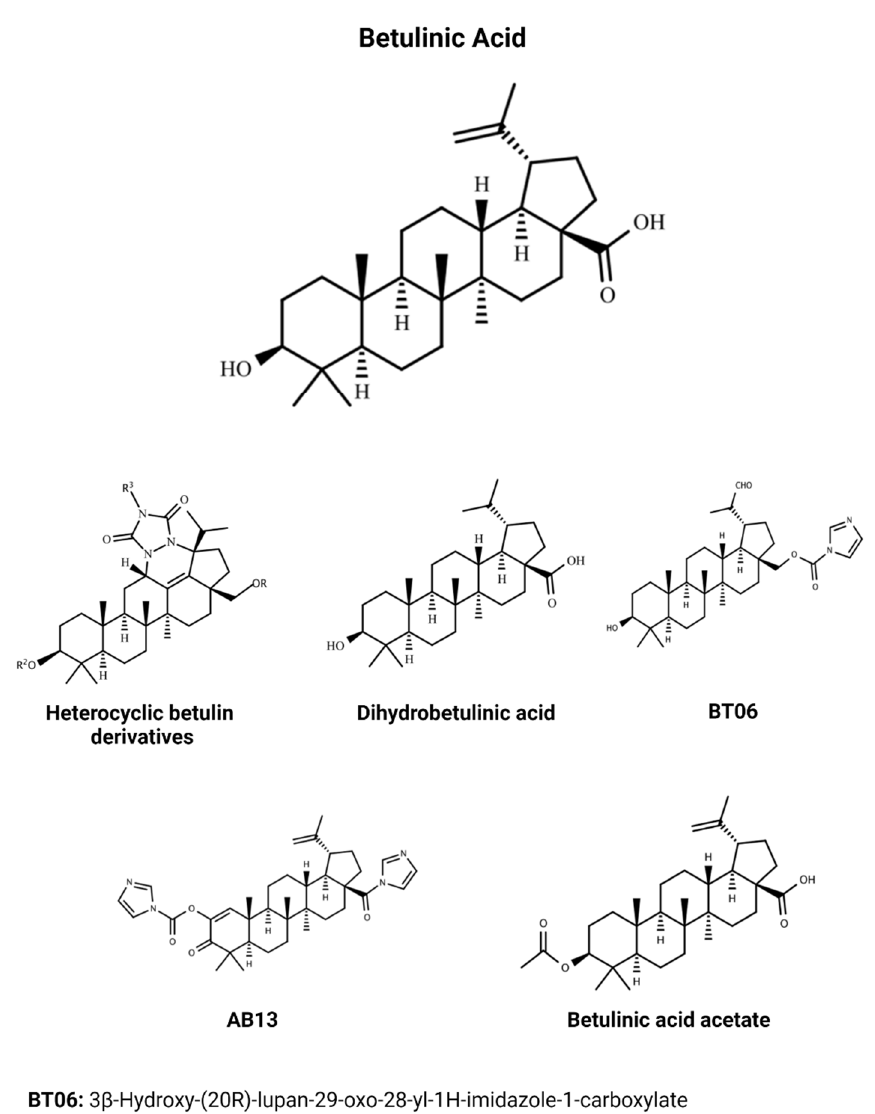
Figure 3. Chemical structures of the main efficacious BA and BA-derivative compounds which presented activity against Leishmania , T. cruzi, and Plasmodium in previous studies. BA structure (CID 64971) was obtained from PubChem [81].